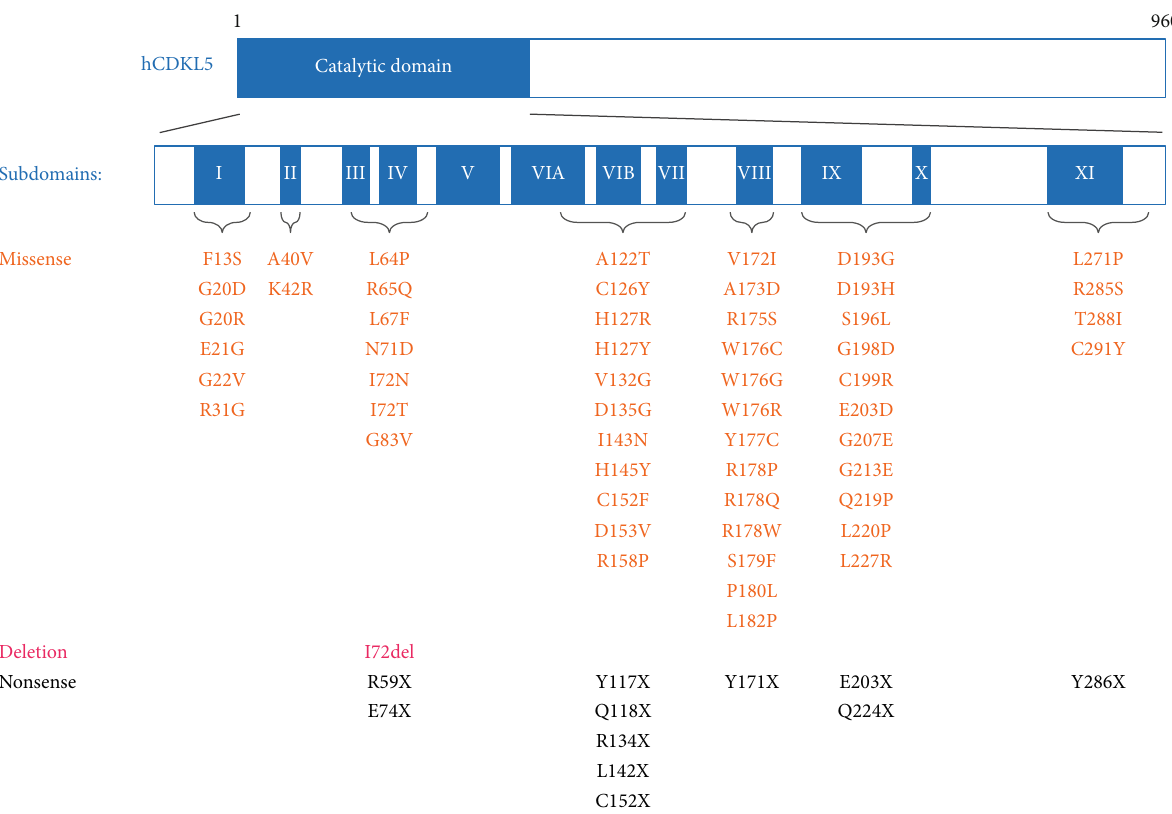
Figure 4: Substitutions in the catalytic domain of CDKL5. CDKL5 has an N-terminal catalytic domain, with a conserved 12-subdomain structure of Ser/Thr kinases. Sites of missense and single amino acid deletion variants extracted from RettBASE (last accessed on September 9 th , 2019), as well as Y177C, a variant discovered by the authors of the current review, are